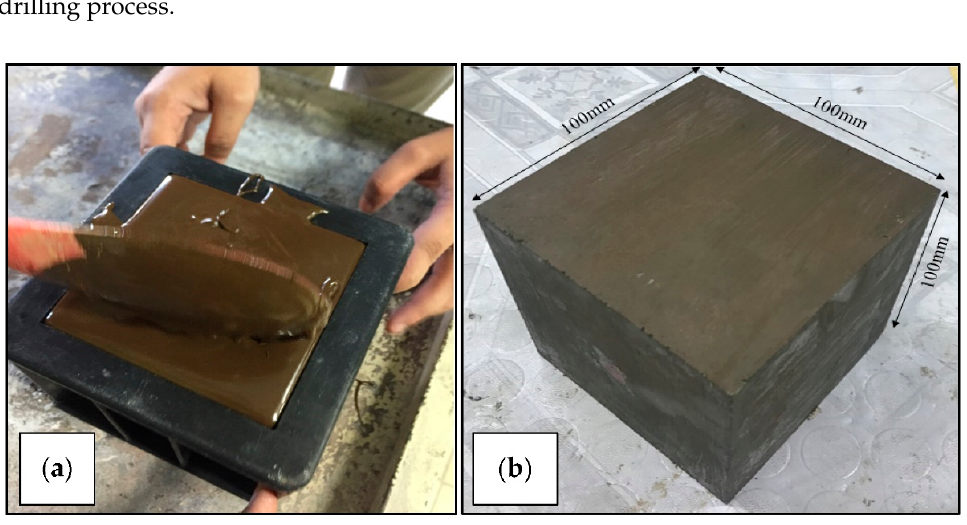
Figure 1. ( a ) Preparation process of geopolymer samples and ( b ) workpiece of fly ash geopolymer after solidified ready for drilling